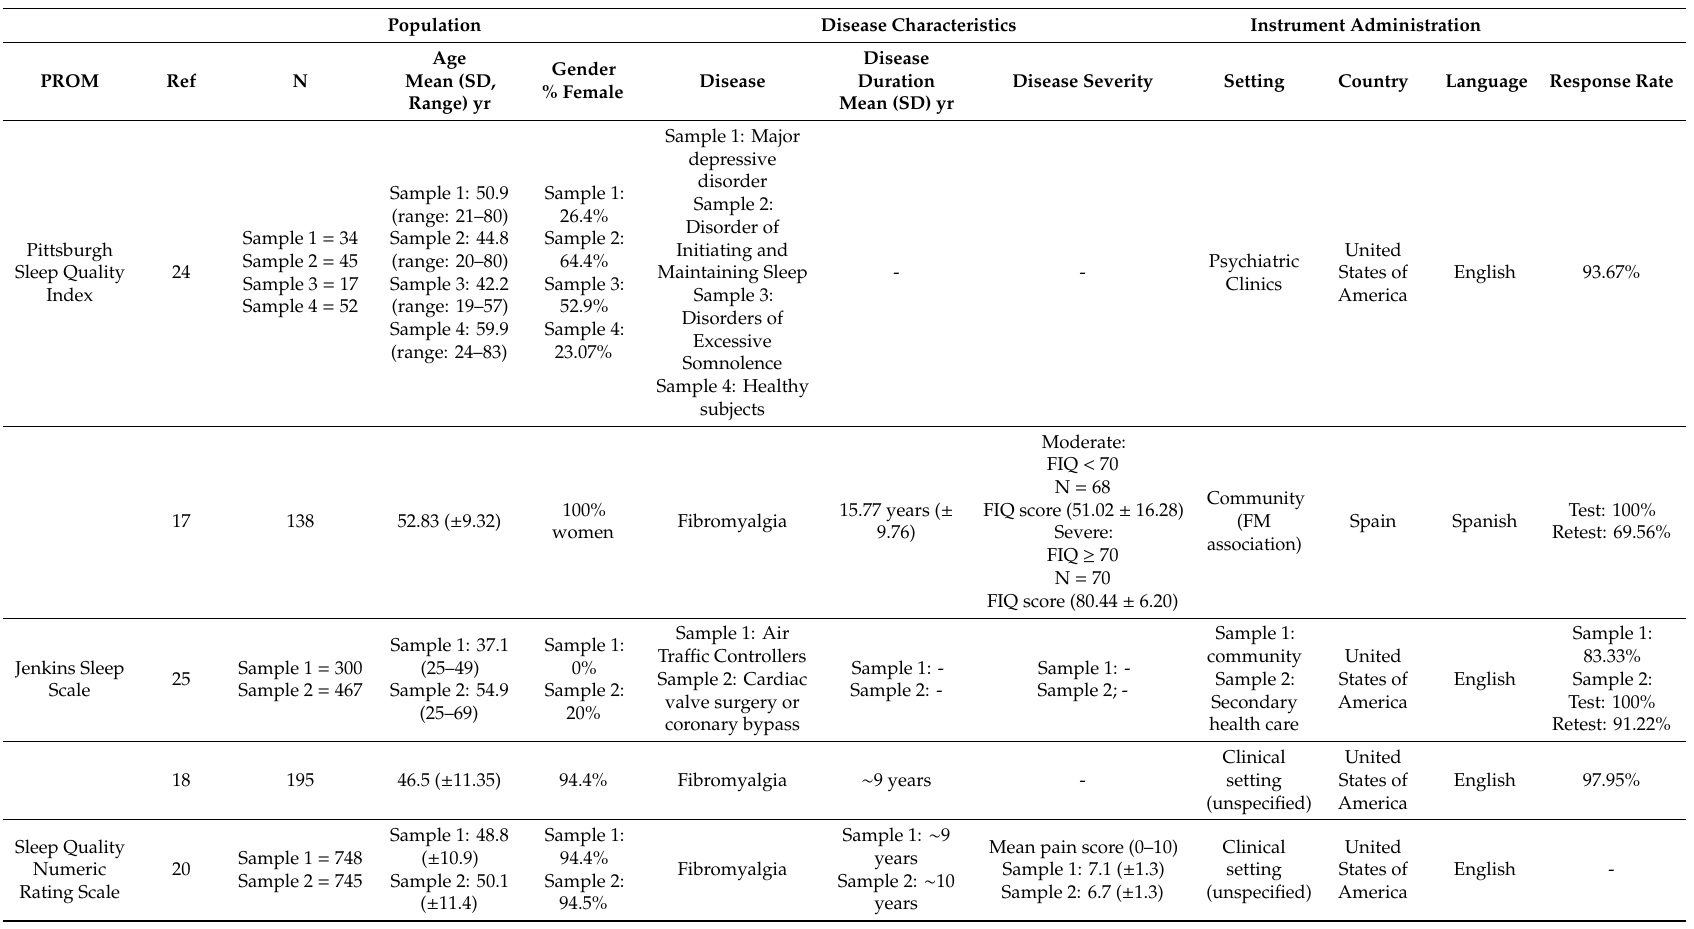
Table 4. Characteristics of the study